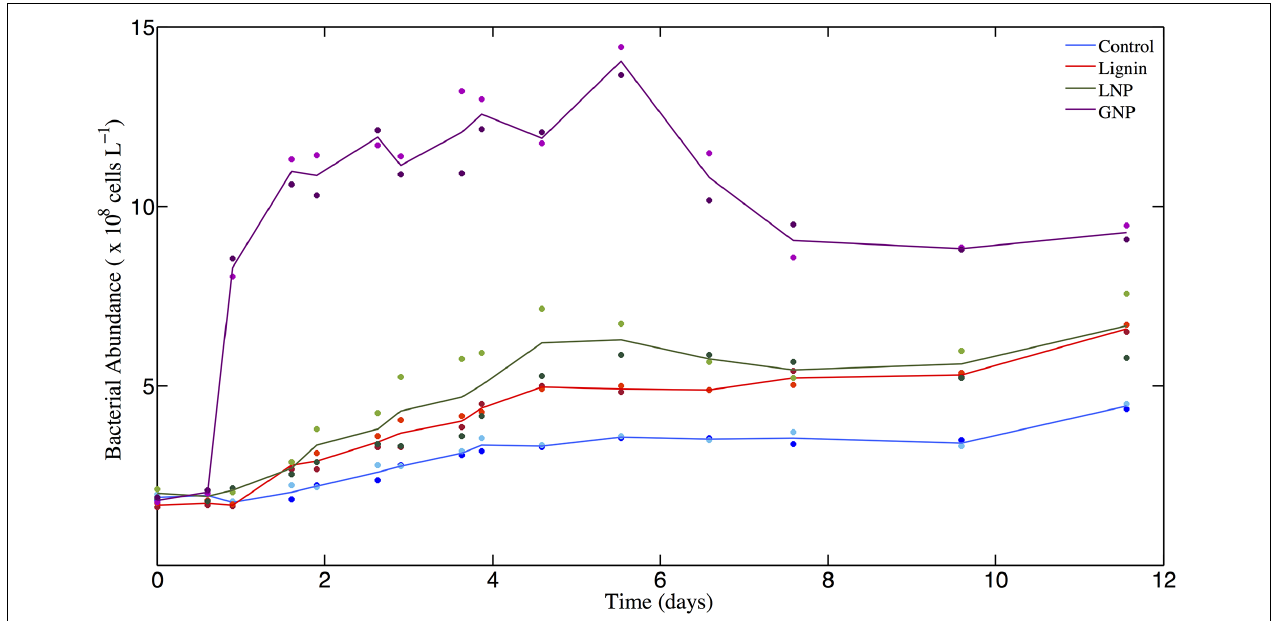
FIGURE 1 | Bacterioplankton cell abundance ( × 10 8 cells L – 1 ) over time (days). Solid lines represent the average of replicates for each of the four treatments: GNP, Lignin, LNP, and un-amended controls. Individual datapoints, representing duplicates for each treatment are color-correlated with the plot of the respective mean.